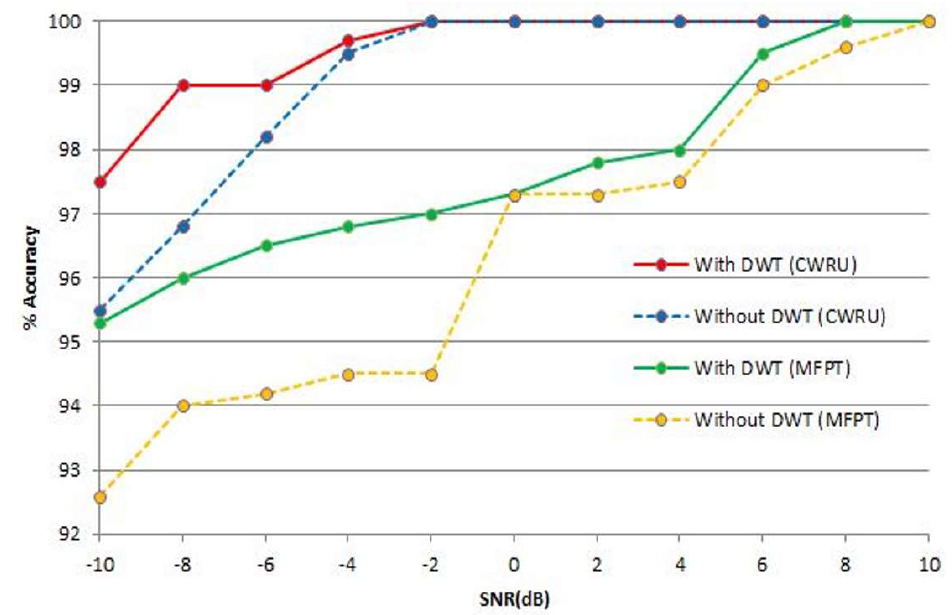
Figure 8. Effect of DWT on the result.